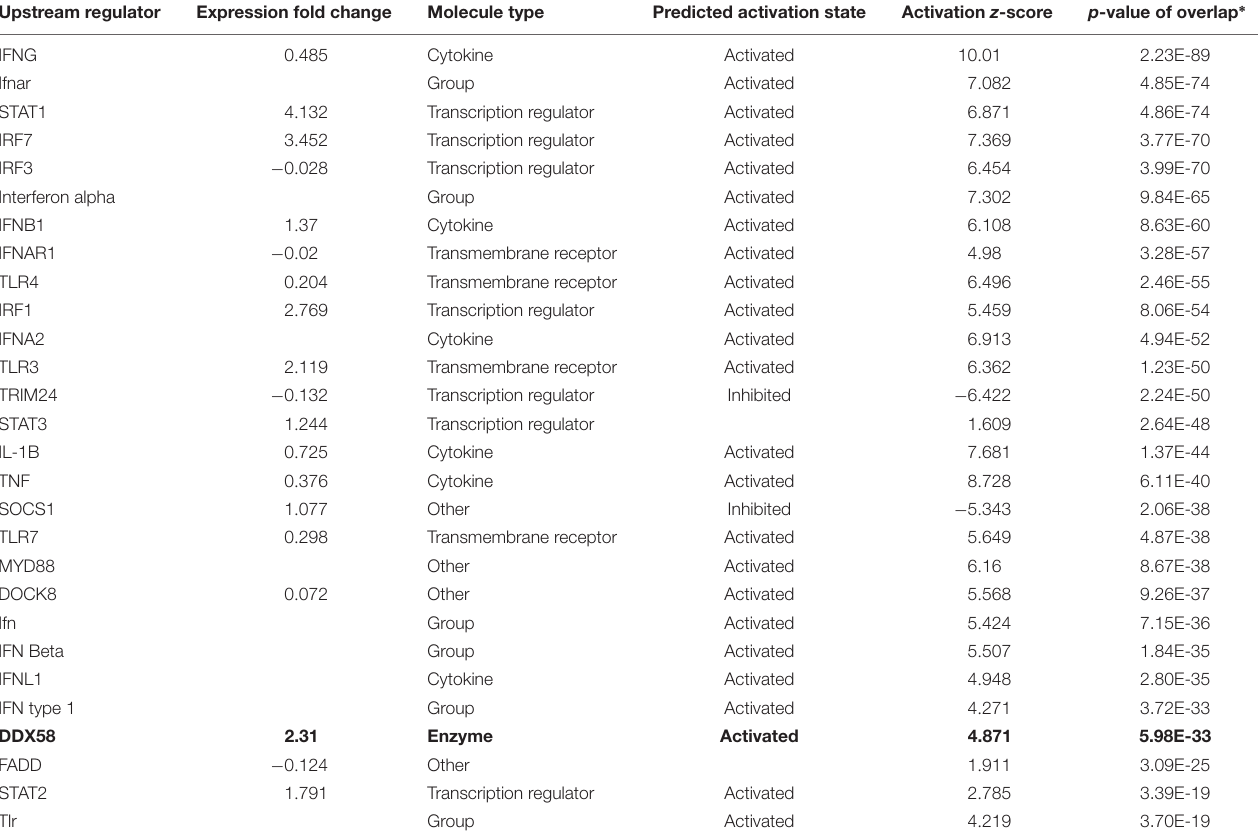
TABLE 1 | Regulators of innate immunity and cell death identified by the URA tool of IPA. Upstream regulator Expression fold change Molecule type Predicted activation state Activation z -score p -value of overlap